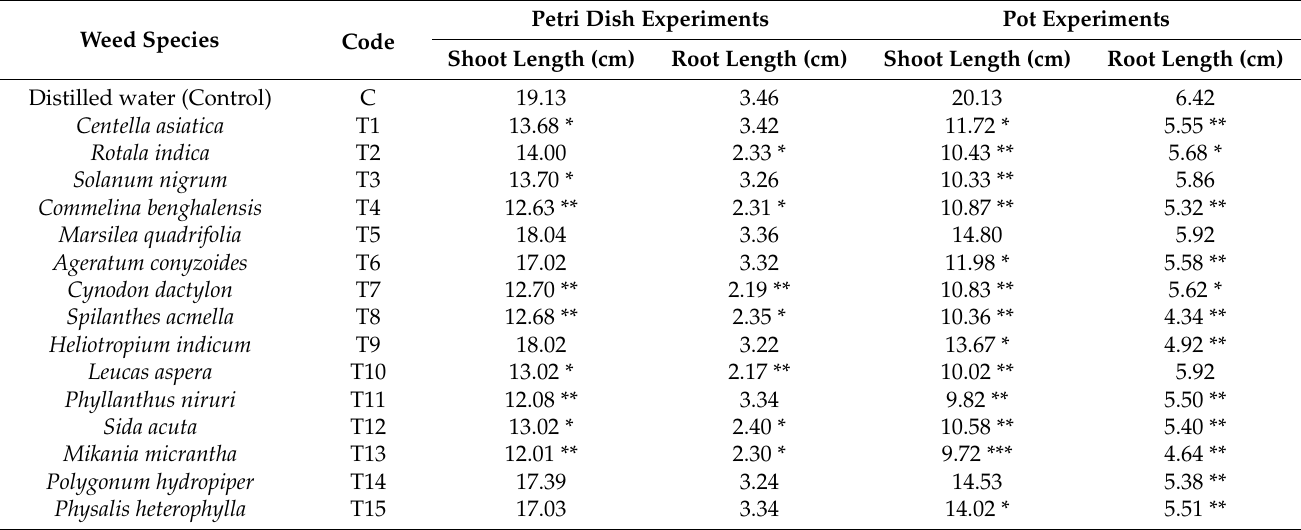
Table 4. Effect of aqueous root exudates of weed species on the length of shoot and roots on T. aestivum